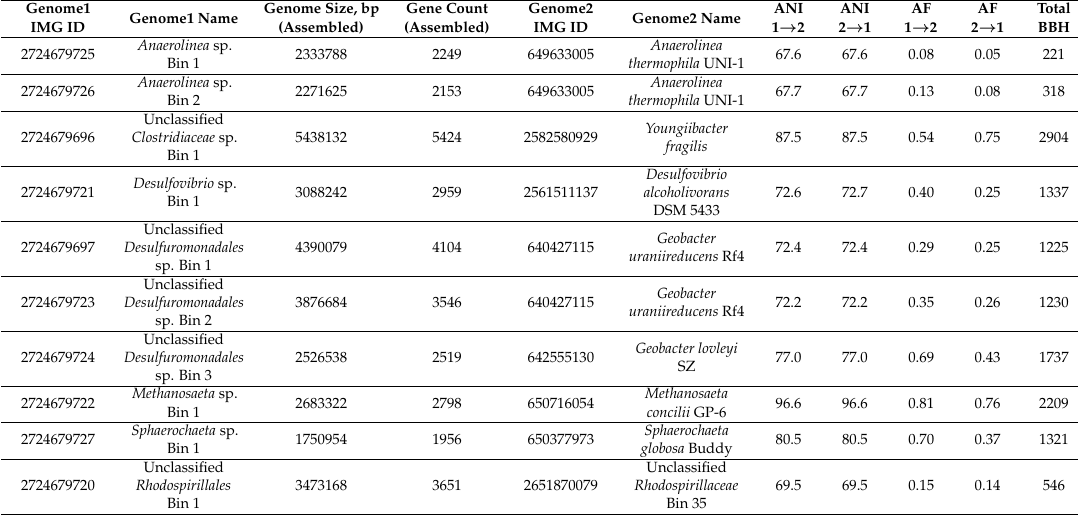
Table 2. Genome sequence similarity of prepared draft genomes to their closest matching cultured representative or enriched strain. Pairwise average nucleotide identity (ANI) calculations were used to assess the bidirectional best hits (BBH) of genes having 70% or more identity to reference strains and at least 70% coverage of the shorter gene. Alignment fraction (AF) calculations were prepared to determine the % coverage of the draft genomes to reference